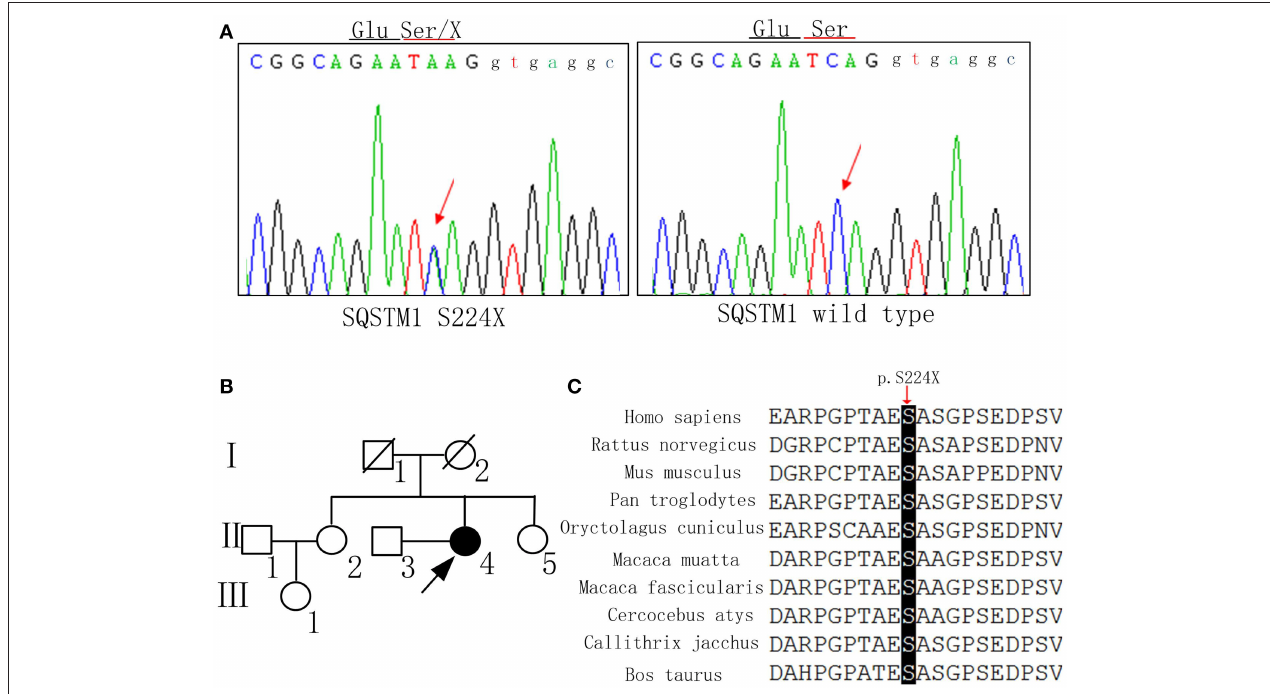
FIGURE 2 | DNA sequence, pedigree of the family, and gene conservation. (A) DNA sequence at codon 224 of SQSTM1 gene from the patient and a control. The arrow indicates a mutated hemizygous site and a normal homozygous site, respectively. (B) The proband is indicated by an arrow (II-4). Her younger sister (II-5) also received the gene test and did not carry the same mutation. (C) The p.S224X heterozygous nonsense mutation occurs at highly conserved position, as shown by a comparison of the corresponding sequences of 10